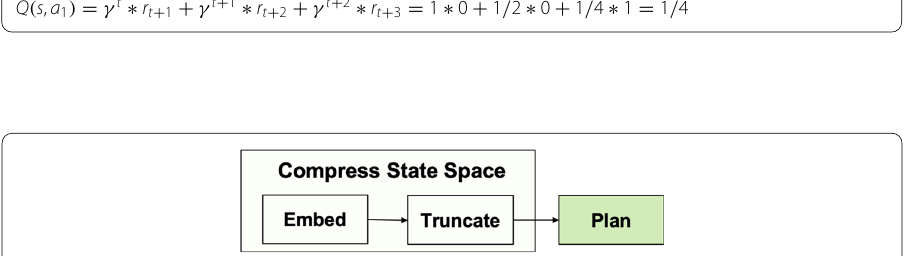
Fig. 2 Schematic approach of NAC algorithm. In the first component, NAC uses a network embedding and truncation step to avoid an explosion in the state‑action space as the network grows. The truncation block ensures a constant size input into the learned policy. In the second component, NAC uses reinforcement learning to learn a policy